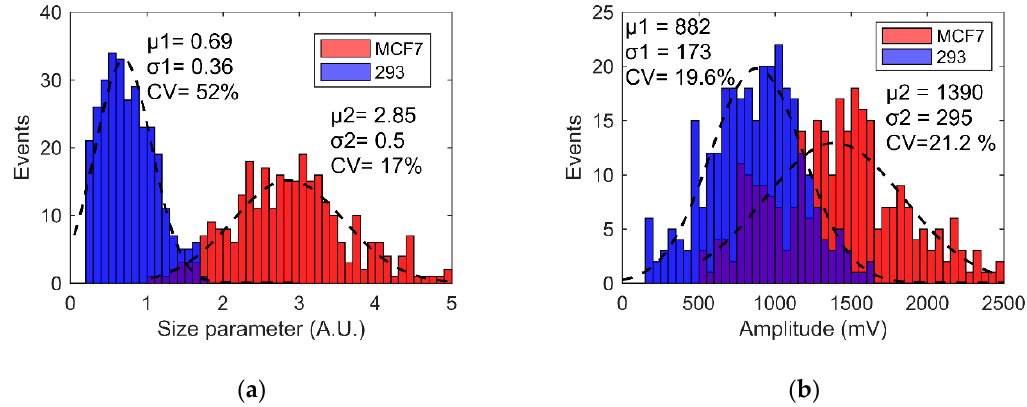
Figure 12. The histogram of MCF7 cells (in red); 293 cells (in blue). ( a ) Size parameter K distribution; ( b ) SMI signal amplitude